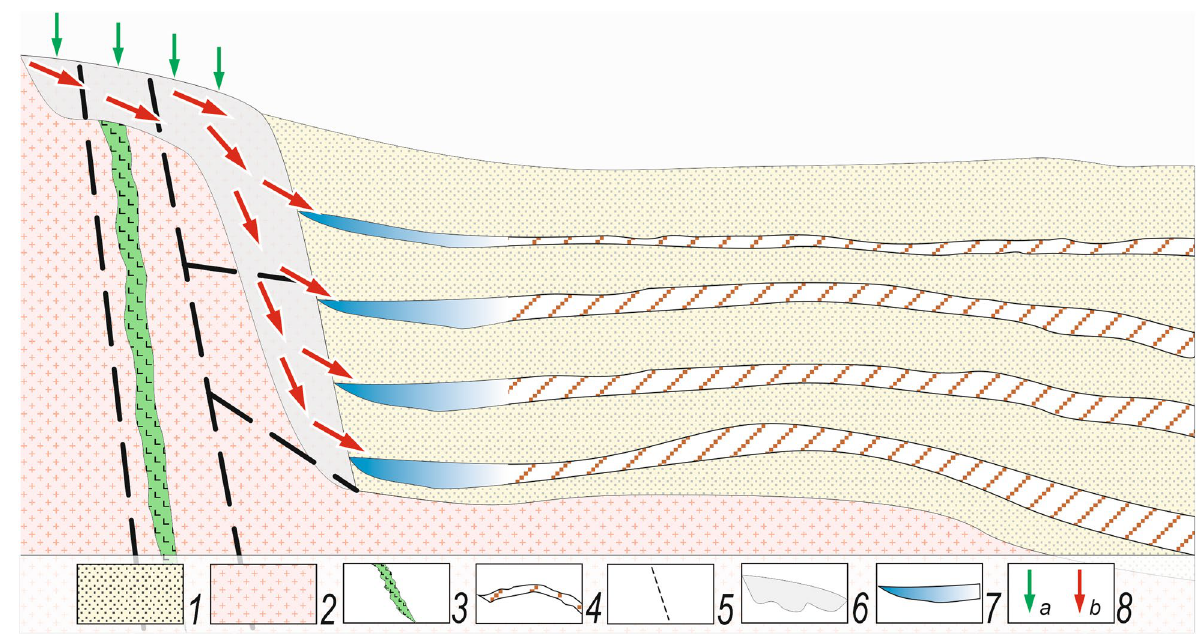
Fig. 8 A model of REE and uranium input into coal-bearing sedi- ments of the Rakovka depression: 1—cenozoic sediments; 2— granites; 3—basic composition dike; 4—peat layers;